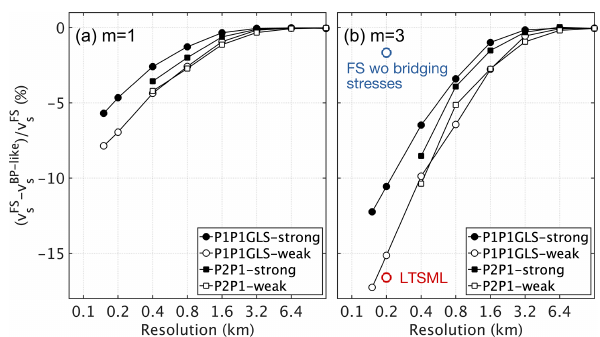
Figure 8. Relative surface velocity differences of area-averaged sur- face velocities between the FS and BP-like stress regimes in the out- let domain. (a) Linear friction law ( m = 1). (b) Non-linear friction law ( m = 3). The blue and red circles show two simulations from a “FS without (wo) bridging stresses” and LTSML-like regimes sim- ulated with P1P1GLS weak (see “Discussion”). For these two stress regimes, differences are calculated relative to FS.